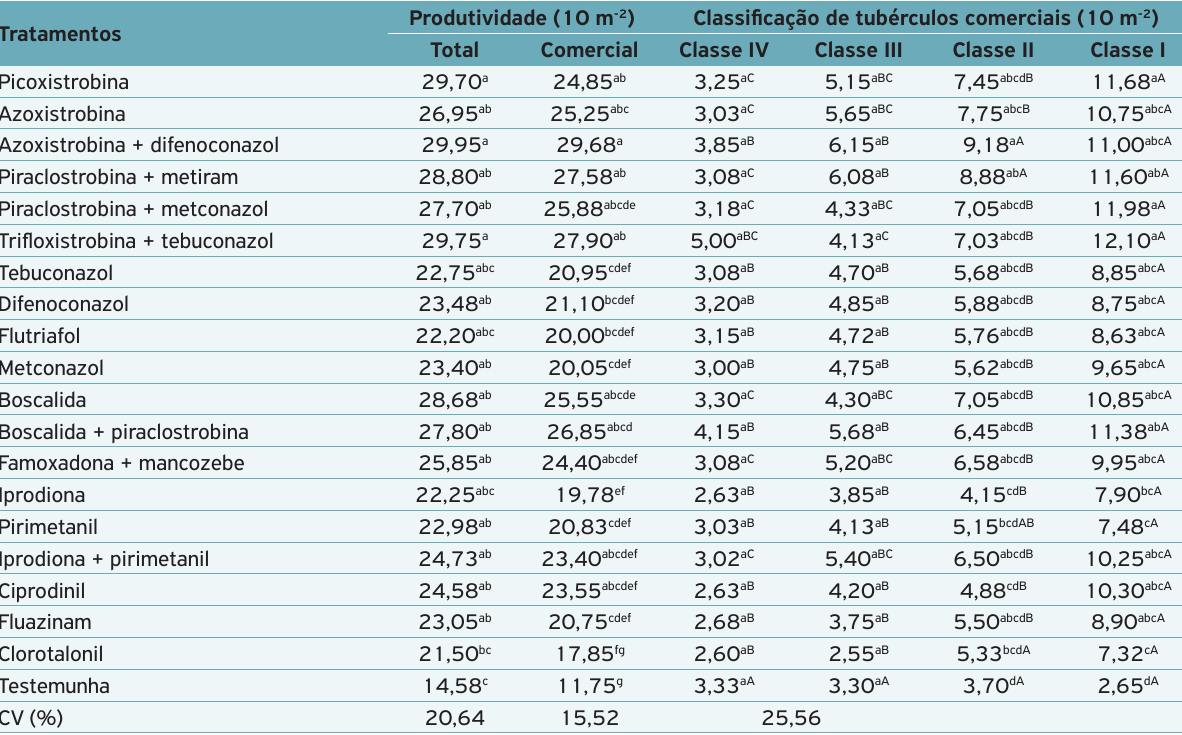
Tabela 4. Produtividade Total, comercial e classificação de tubérculos comerciais obtidos de plantas de batata (cultivar Monalisa) tratadas com fungicidas. Pilar do Sul, São Paulo, outubro a dezembro 2009.